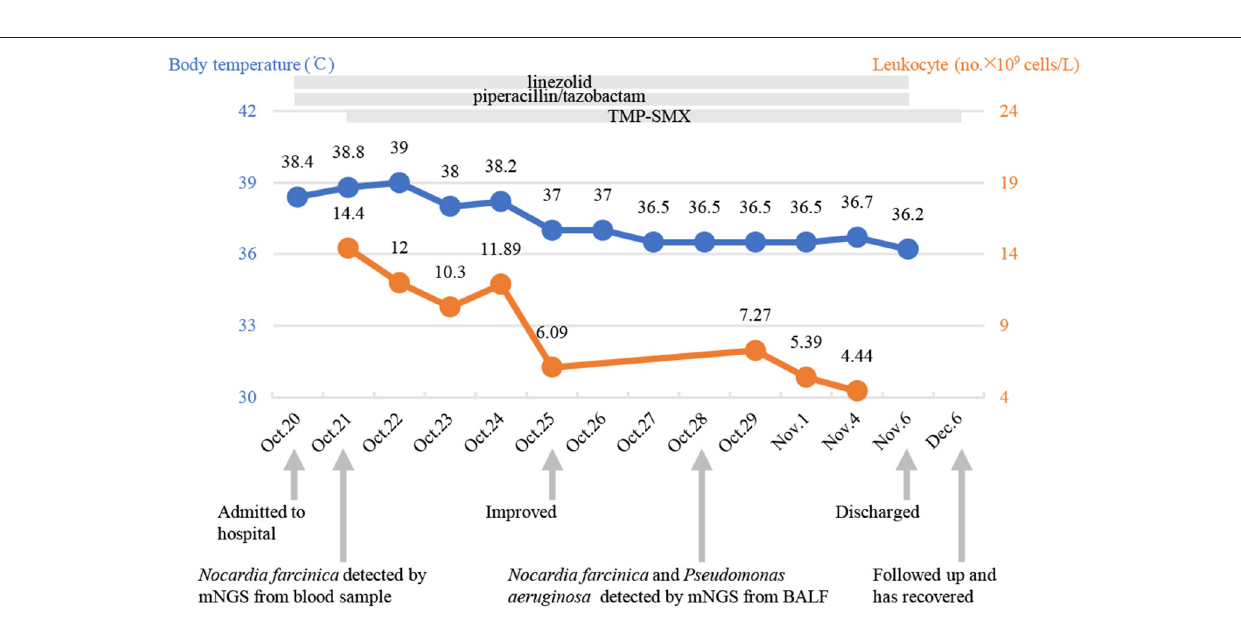
FIGURE 3 | Timeline with relevant data from the case in our hospital; curves of body temperature and leukocyte counts. The arrows below indicate major events. Blue line shows body temperature values. Orange line shows leukocyte counts. TMP-SMX, trimethoprim-sulfamethoxazole; mNGS, metagenomic next-generation